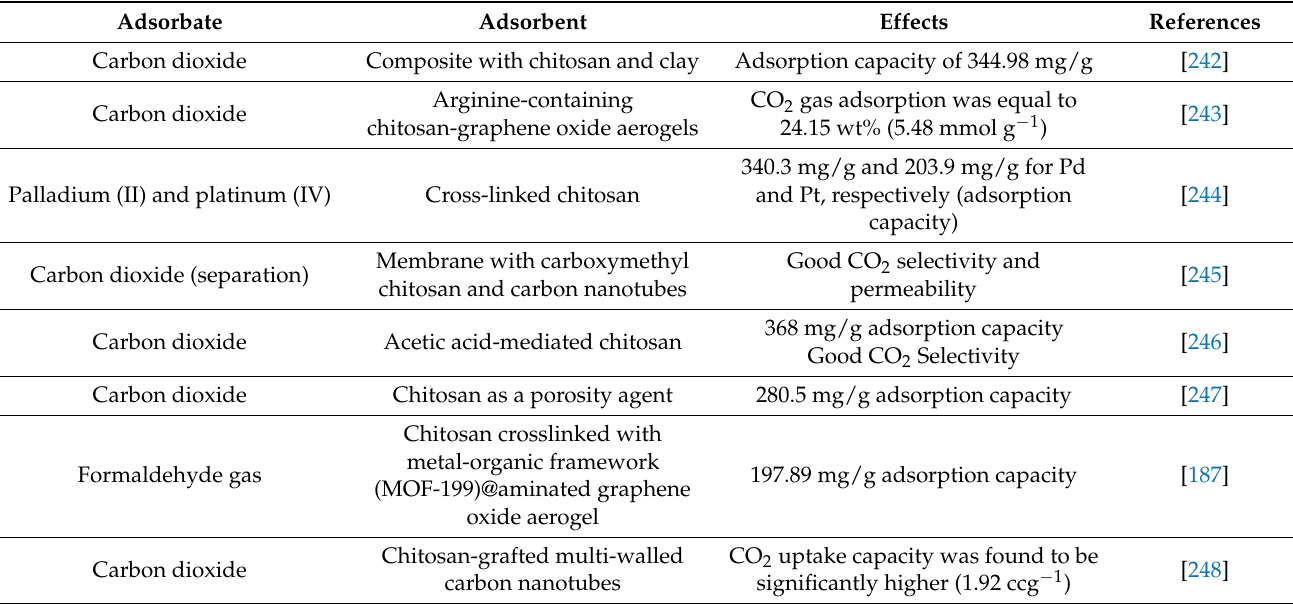
Table 10. Chitosan-based materials used for gas